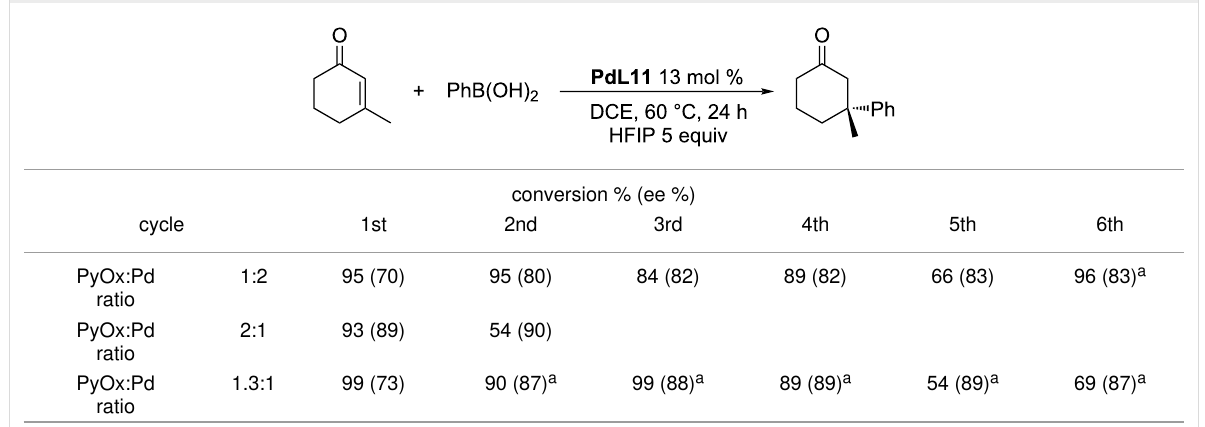
Table 30: Recyclisation of the polystyrene-supported Pd complex PdL11